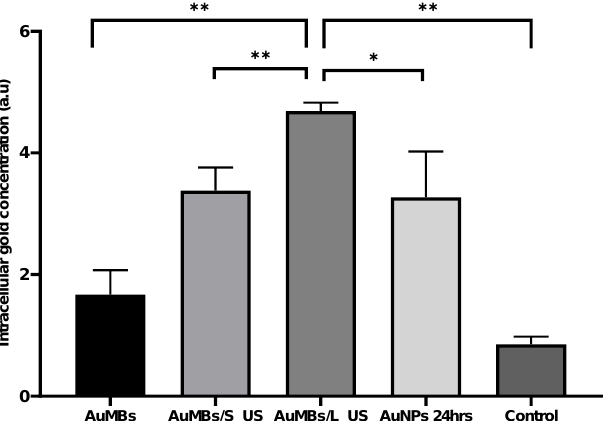
Figure 4. Results of a quantitative analysis of the intracellular uptake of AuNPs by ICP-MS. Long-duration acoustic sonoporation (pulse duration = 30 µs) was associated with a significantly higher intracellular concentration of AuNPs compared to short-duration (pulse duration = 10 µs) acoustic stimulation and negative controls. Data are mean and SD values from three independent experiments. * p < 0.05, ** p < 0.005.